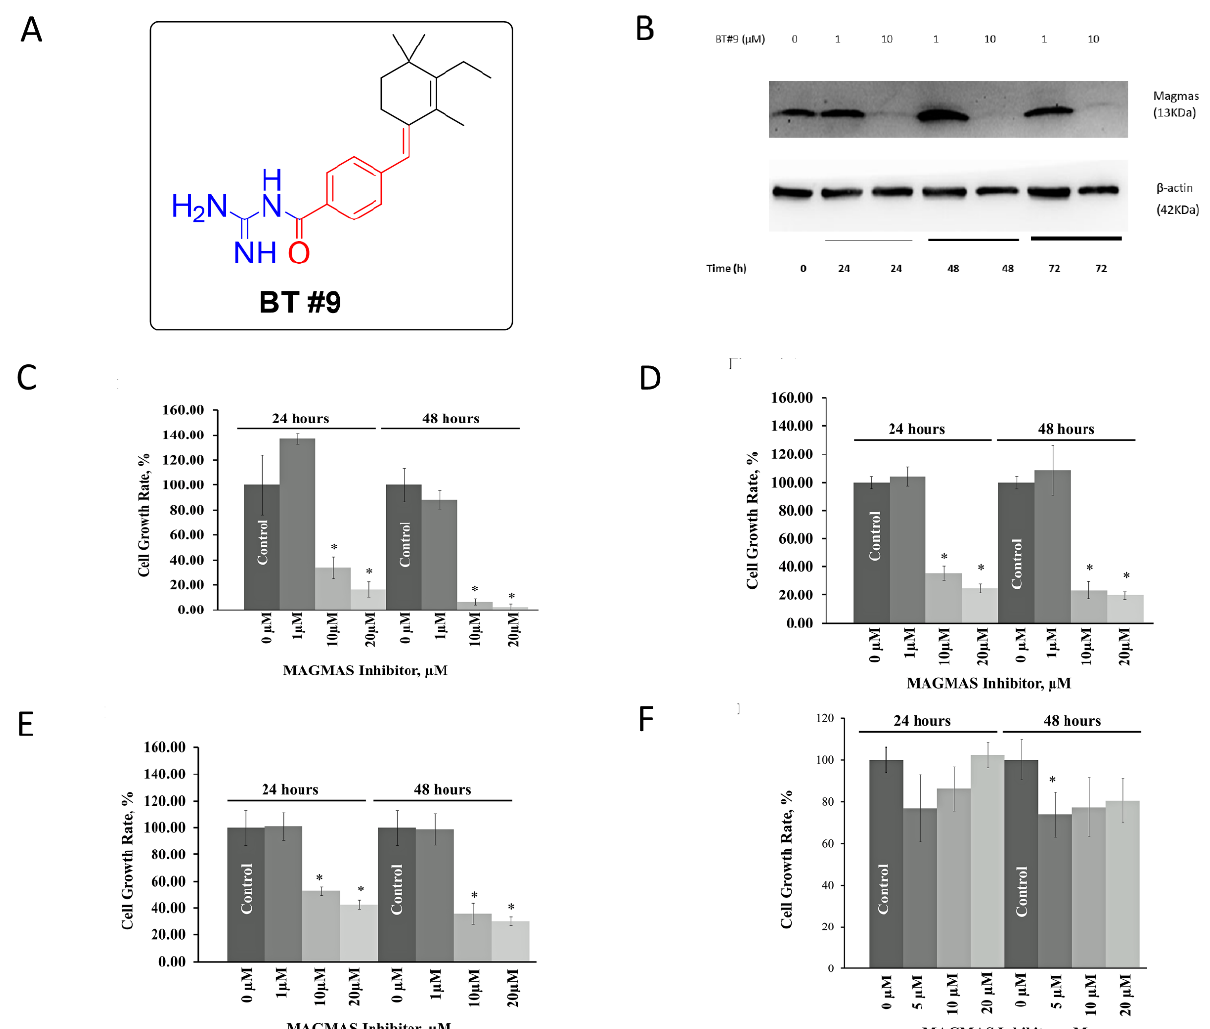
Figure 3. The effect of BT#9 on the protein expression of Magmas and the cell viability of prostate cancer cells and normal prostate cells. ( A ) Chemical Structure of Magmas Inhibitor BT#9. ( B ) Magmas protein in DU-145 cells was significantly downregulated by BT#9 (10 μ M) at 24,48 and 72 h. ( C ) MTT assay for the cell viability analysis of DU145 cells treated with various concentrations of BT9 (0, 1, 10 and 20 μ M) for 24 and 48 h. ( D ) MTT assay for the cell viability analysis of PC3 cells treated with various concentrations of BT9 (0, 1, 10 and 20 μ M) for 24 and 48 h. ( E ) MTT assay for the cell viability analysis of LNCaP cells treated with various concentrations of BT9 (0, 1, 10 and 20 μ M) for 24 and 48. ( F ) MTT assay for the cell viability analysis of WPMY-1 cells treated with various concentrations of BT9 (0, 5, 10 and 20 μ M) for 24 and 48 h. Each experiment was repeated three times. * p < 0.05 (Unpaired two-tailed t test).